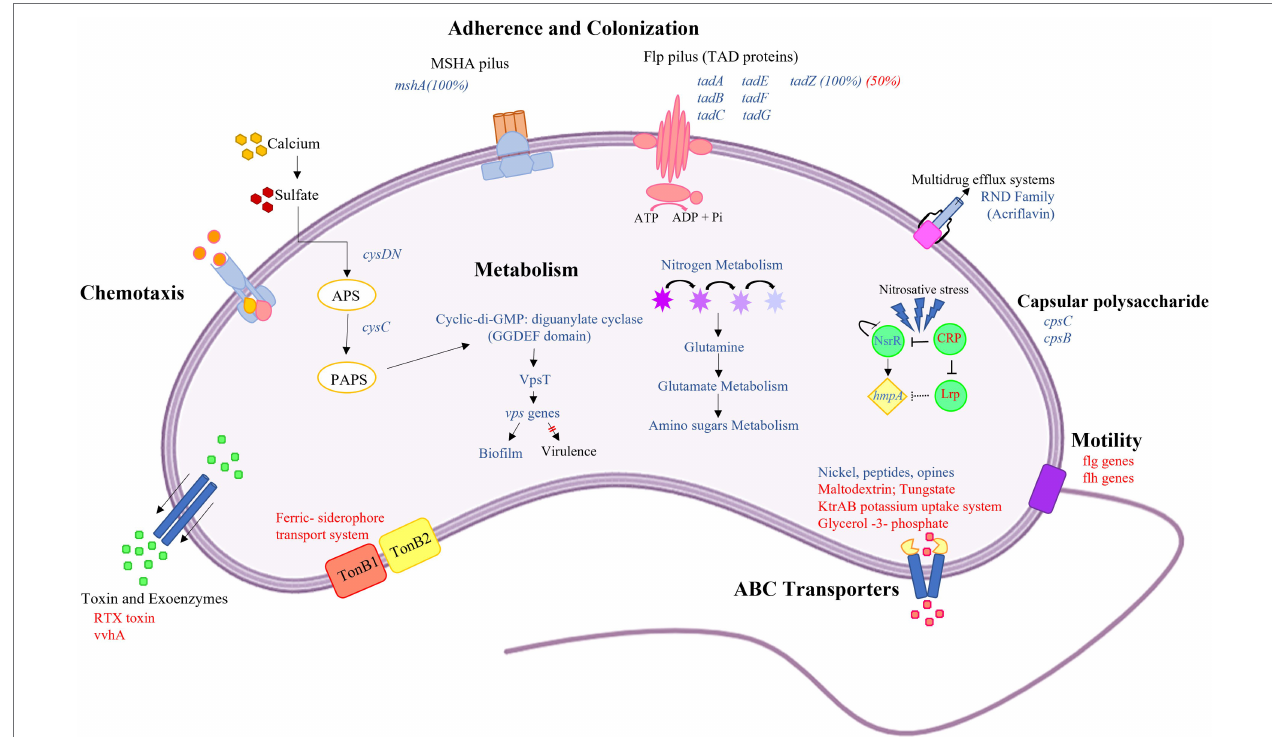
FIGURE 3 | Graphical summary of altered Vibrio vulnificus gene expression or pathways with exposure to wastewater effluent. This graphic shows the differentially expressed genes (FDR-adjusted value of p ≤ 0.05) in V. vulnificus exposed to wastewater effluent compared with the 0% wastewater control. The blue and red text represent upregulated and downregulated genes, respectively. Briefly, V. vulnificus exposed to effluent increased transcripts related to attachment and biofilm formation, including Flp pilus ( tad genes) and MSHA pilus. This transition from planktonic to biofilm formation is driven by the action of diguanylate, which resulted in a high level of intracellular cyclic-di-GMP. This switch in growth state is further supported by the downregulation of flagellar genes (motility) and upregulation the sulfate assimilation genes cysDN and cysC by calcium as primary environmental signal. In addition, the genes associated with nitrogen metabolism are upregulated suggesting exposure to wastewater effluent alters bacterial metabolism. Increased transcripts for genes involved in substrate binding and transport systems, such as ATP-binding cassette (ABC) transporter and multidrug efflux systems, suggest increased potential for substrate translocation. Lastly, upregulation of the hmpA gene suggests that exposure to wastewater effluent acts as a source of nitrosative stress, possibly due to increased nitrogen